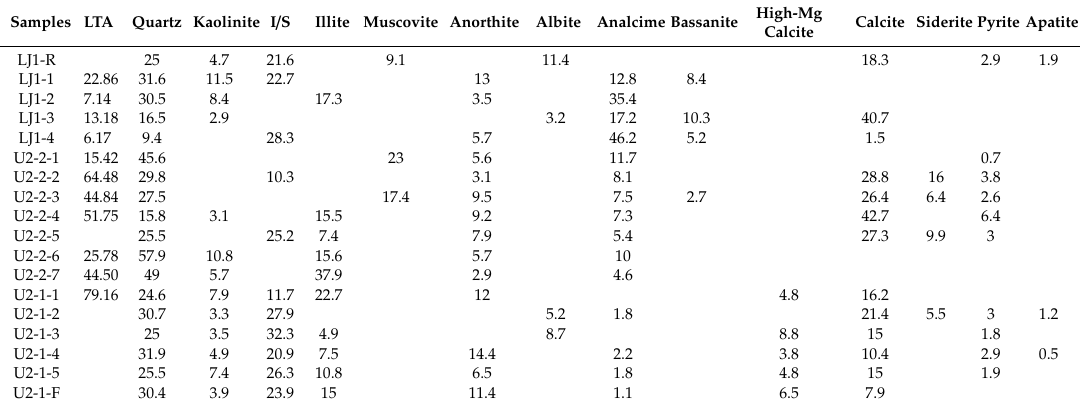
Table 4. Mineral compositions of coals, oil shales, roof and floor samples by XRD and Siroquant (wt%, on organic matter-free